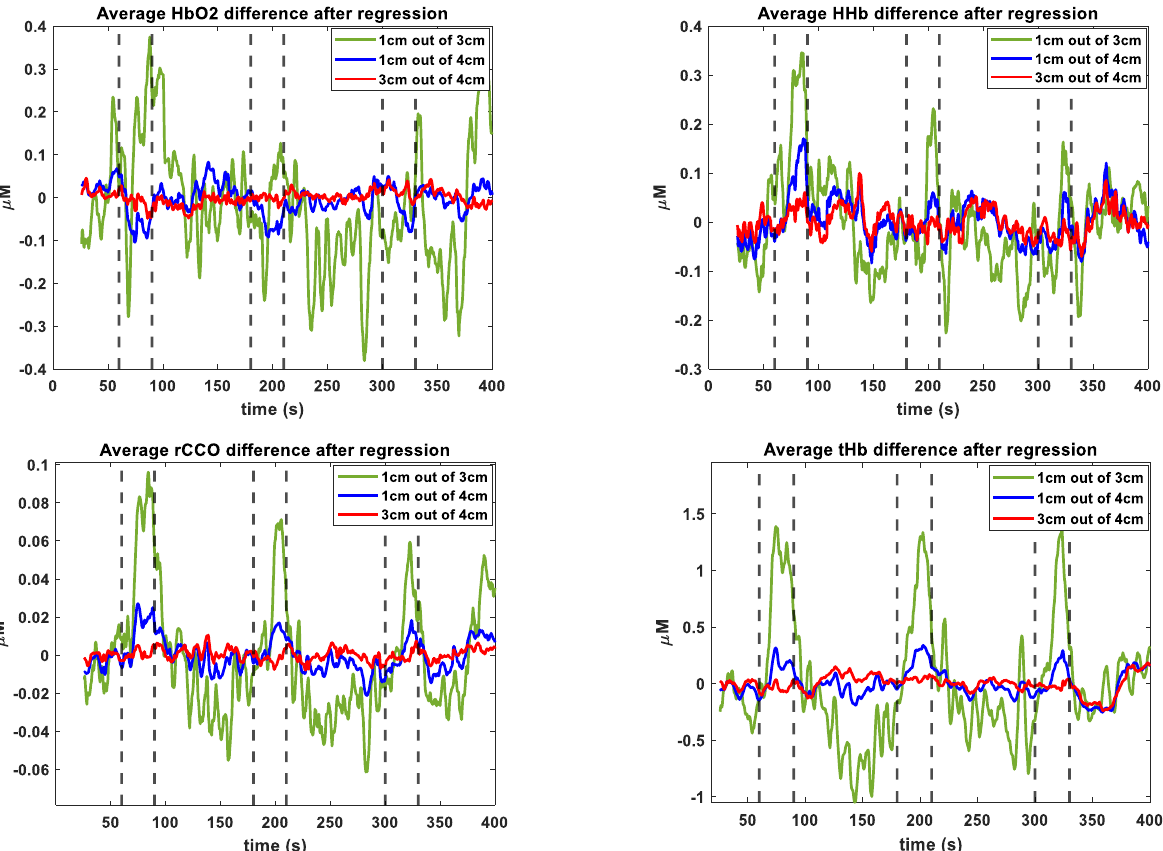
Figure 7. Cross-subject averaged changes in [HbO 2 ], [HHb], [tHB], and [rCCO] calculated from the time-domain regression residuals using stepwise linear regression in spectral domain.